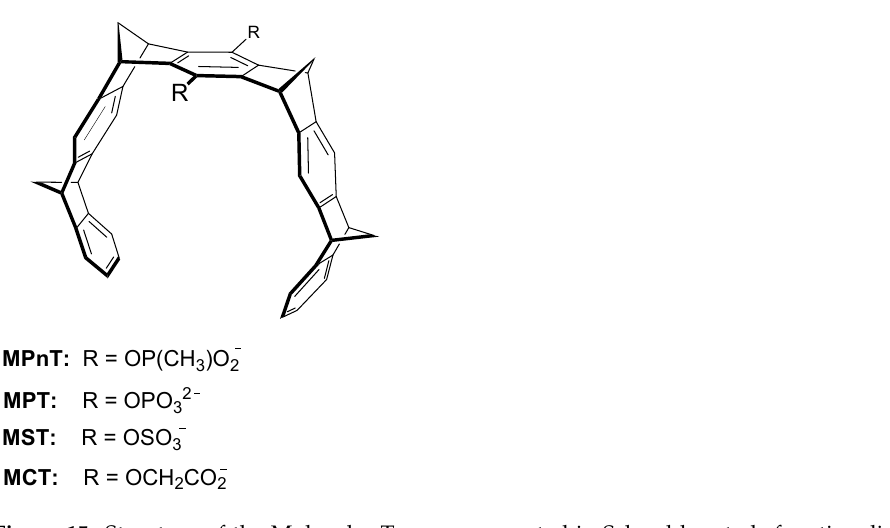
Table 1. Binding constants ( K a ) for the formation of host-guest complexes between amino acids and synthetic supramolecu-